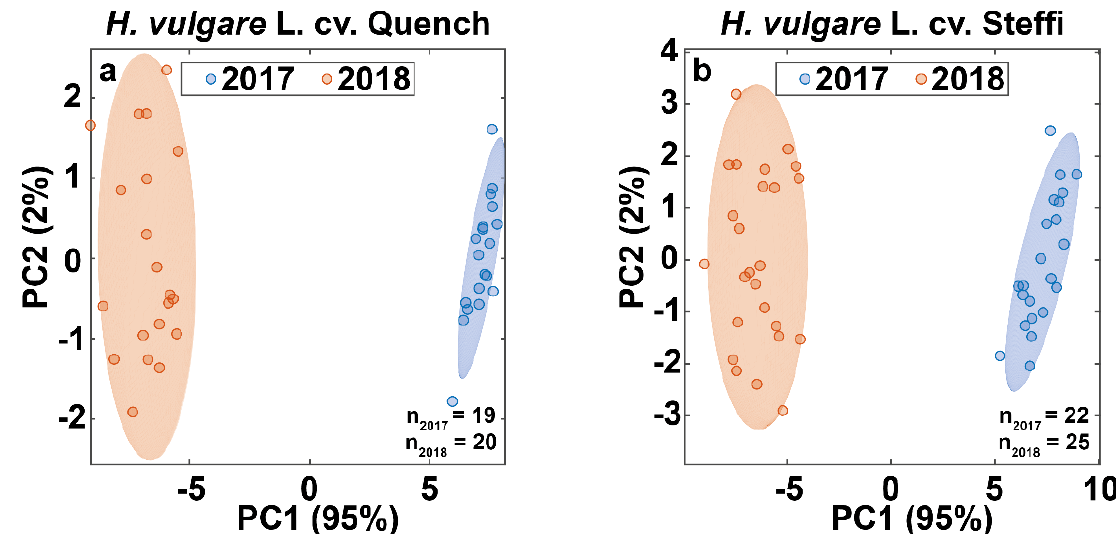
Figure 5. Chemometric analysis of combined FT-NIR and IRMS data. Score plots including 95% confidence ellipses of the first two principal components from the PCA of fused data (FT-NIR and IRMS). Plots are displayed for the two spring barley varieties ( a ) Quench and ( b ) Steffi, and the samples are colored by the crop years 2017 (blue) and 2018 (red). For each principal component, the respective percentage of variance explained is given in the axis label.